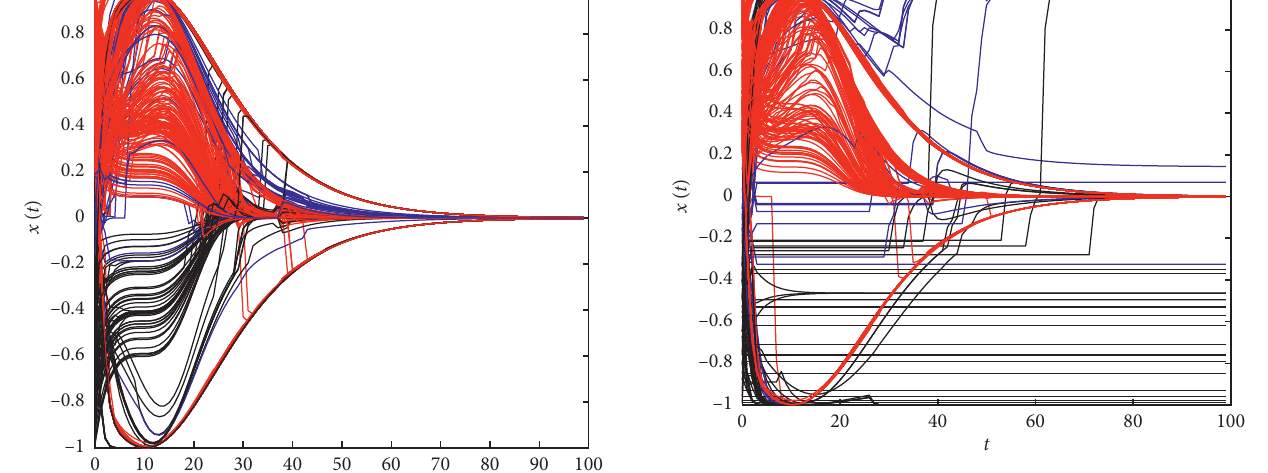
Figure 4: Evolution of individual opinions (II).